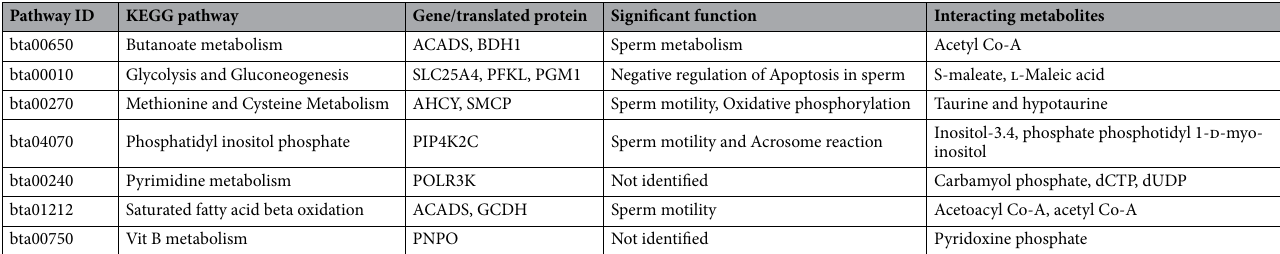
Table 5. The integrated multi-omics data analysis revealed genes, proteins and metabolites that potentially correlate with bull